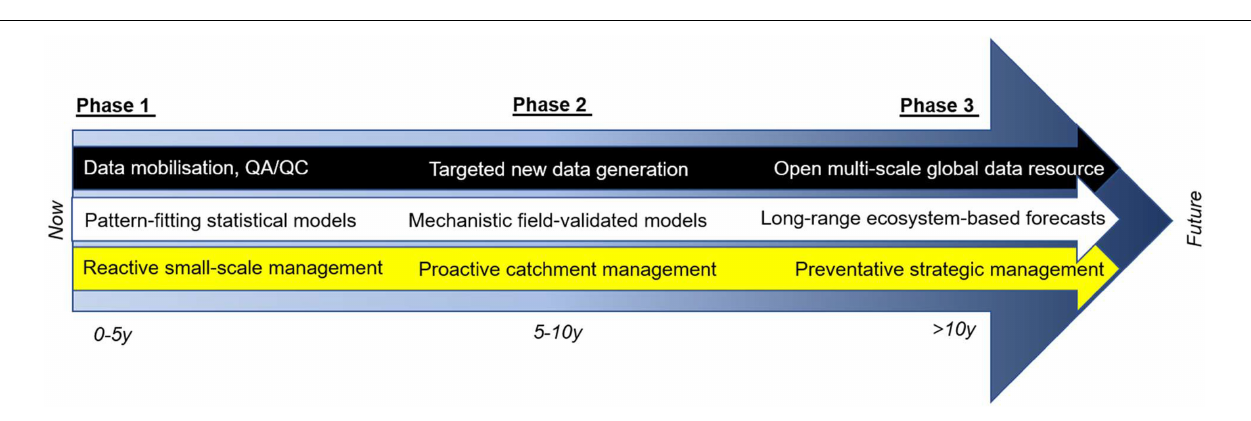
FIGURE 3 | Projected timeline of prioritized actions to advance the field and build ecosystem-based predictive capacity over the next decade, with increasing emphasis on the marine phase to span the full life cycle as data and models